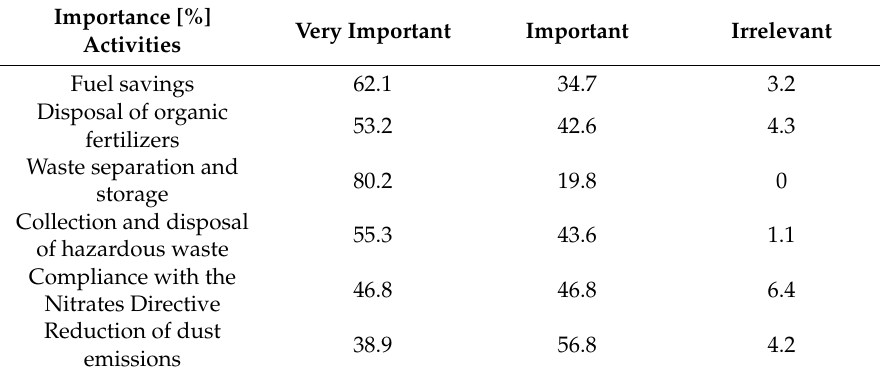
Table 9. Perception of the importance of green logistics activities.